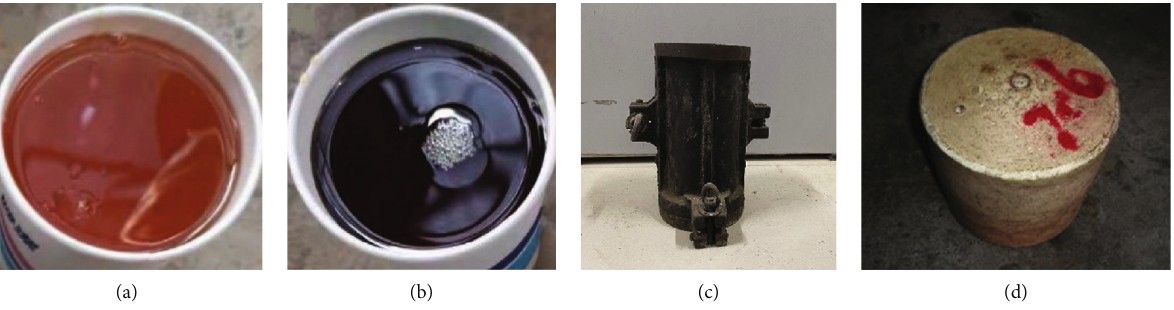
Figure 4: (a) Component A: polyols; (b) component B: isocyanates; (c) mould; (d) polyurethane